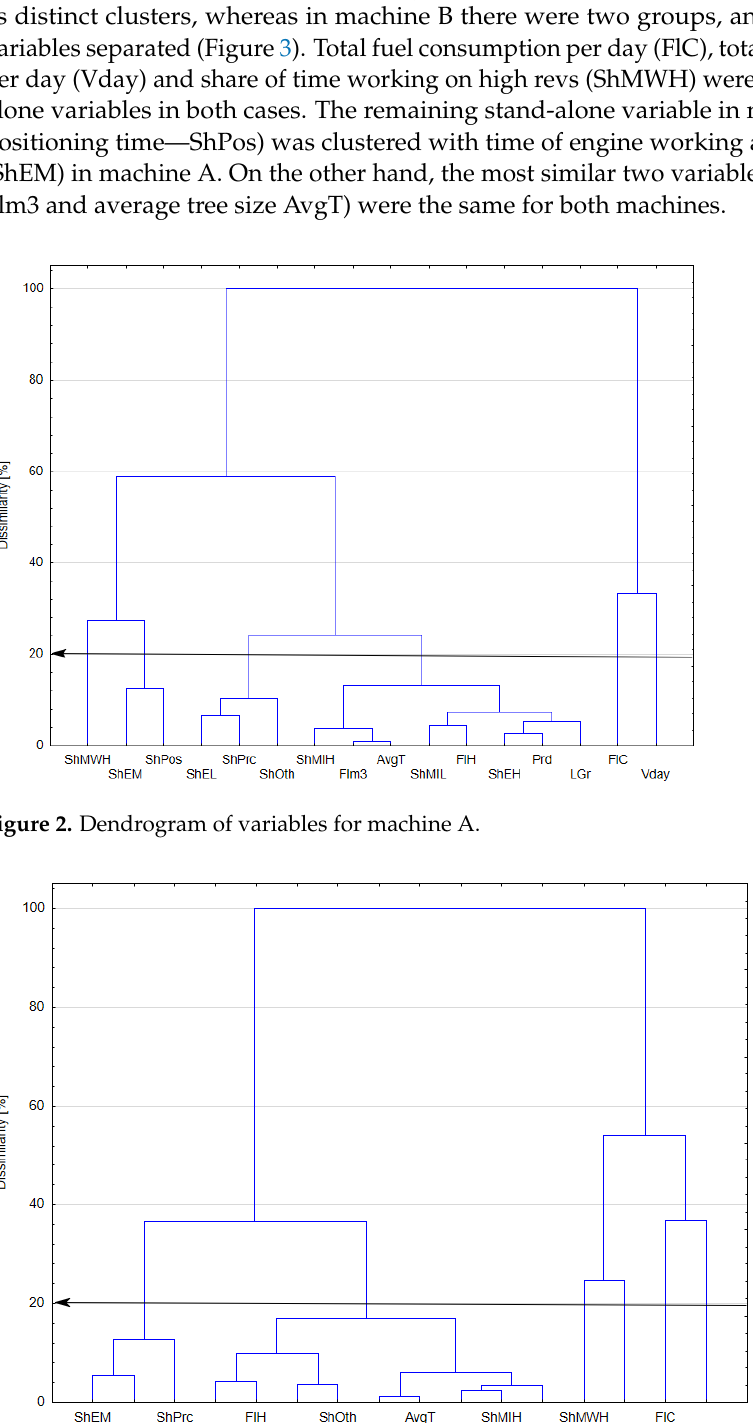
Figure 1. Relationship between mean tree size (AvgT) and relative fuel consumption (Flm3) per cubic meter; each point represents a working day.